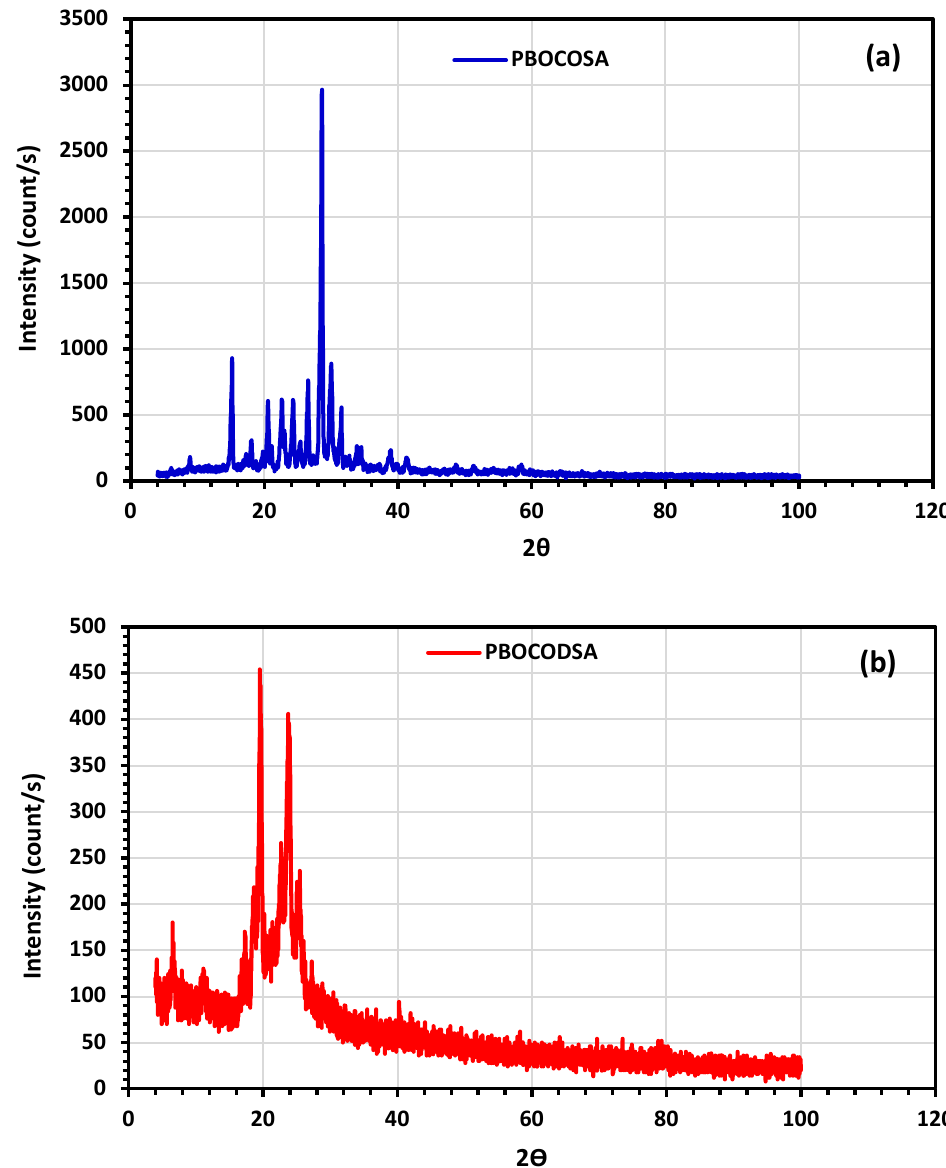
Figure 3. XRD of ( a ) PBOCOSA and its amided copolymer ( b ) PBOCODSA.